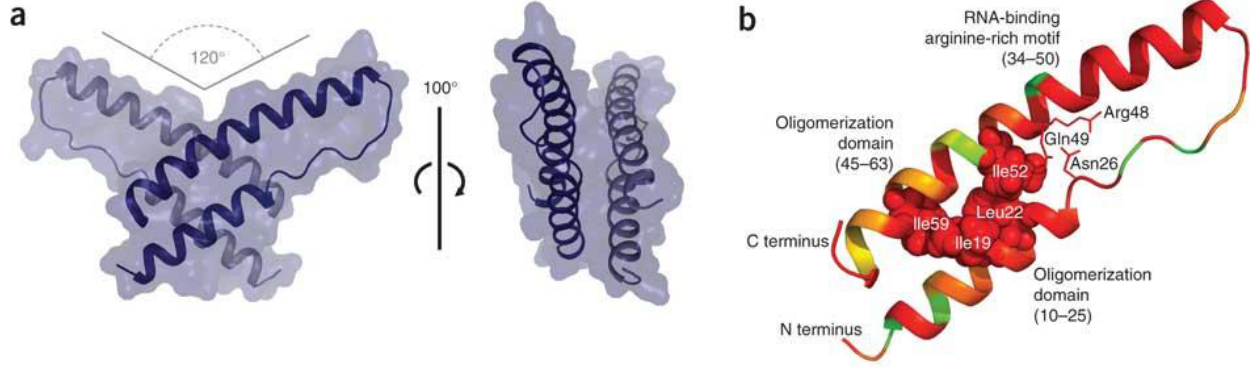
Figure 1. Structure of the Rev Dimer. ( a ) Two views of a surface representation of dimer are shown. ( b ) The folded core of a Rev monomer with its functional domains highlighted is shown. The amino acids prominent in mediating the core structure are specified. The different colors of the ribbon indicate amino acid conservation among 1201 HIV-1 isolates in the Los Alamos Sequence Database, with green representing the least conservation (26%) and red the highest (100%). Reprinted with permission from Macmillan Publishers Ltd: Nature Structural & Molecular Biology 17, 1337–1342 (2010)